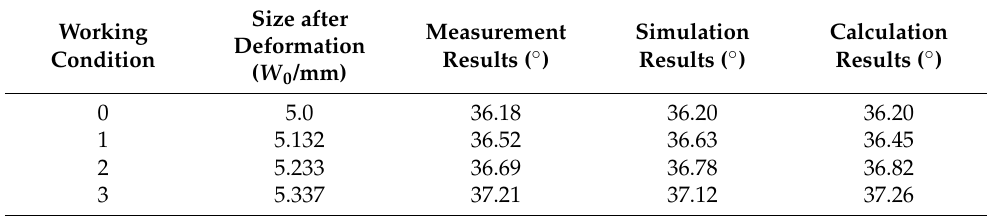
Figure 20. Mode 4 antenna radiation pattern under four working conditions. ( a ) Working condition 0; ( b ) working condition 1; ( c ) working condition 2; ( d ) working condition 3. Table 16. Maximum radiation direction of the Mode 3 antenna under four working conditions.